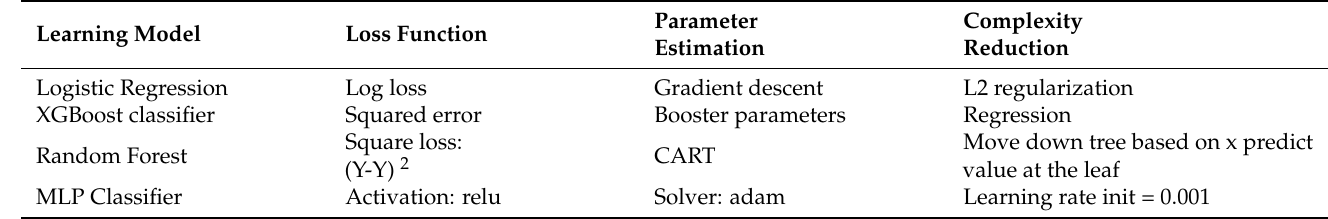
Table 1. Parameters used in different machine learning